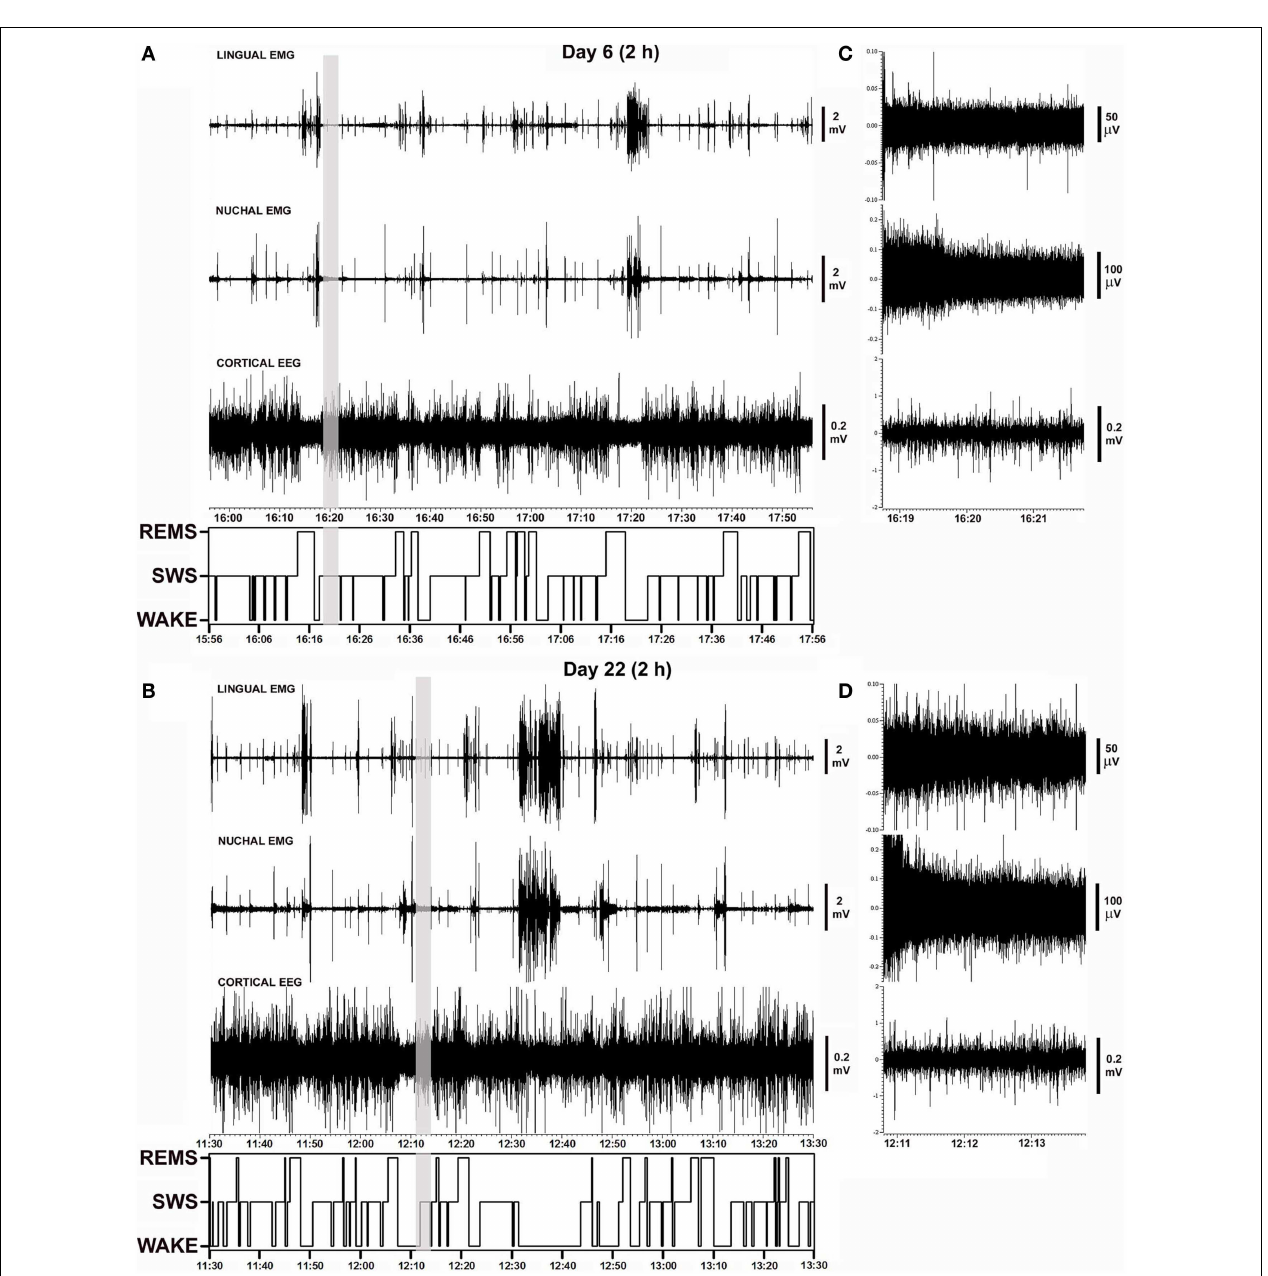
activity associated with active wakefulness. (C,D) Nine minutes-long segments of the records marked by the vertical gray lines in (A,B) shown using expanded time and amplitude scales.The segments are taken from SWS periods when lingual muscles are atonic or nearly atonic.The records demonstrate a close similarity of activity patterns, sleep–wake patterns, and noise levels recorded from the same animal 16days apart.